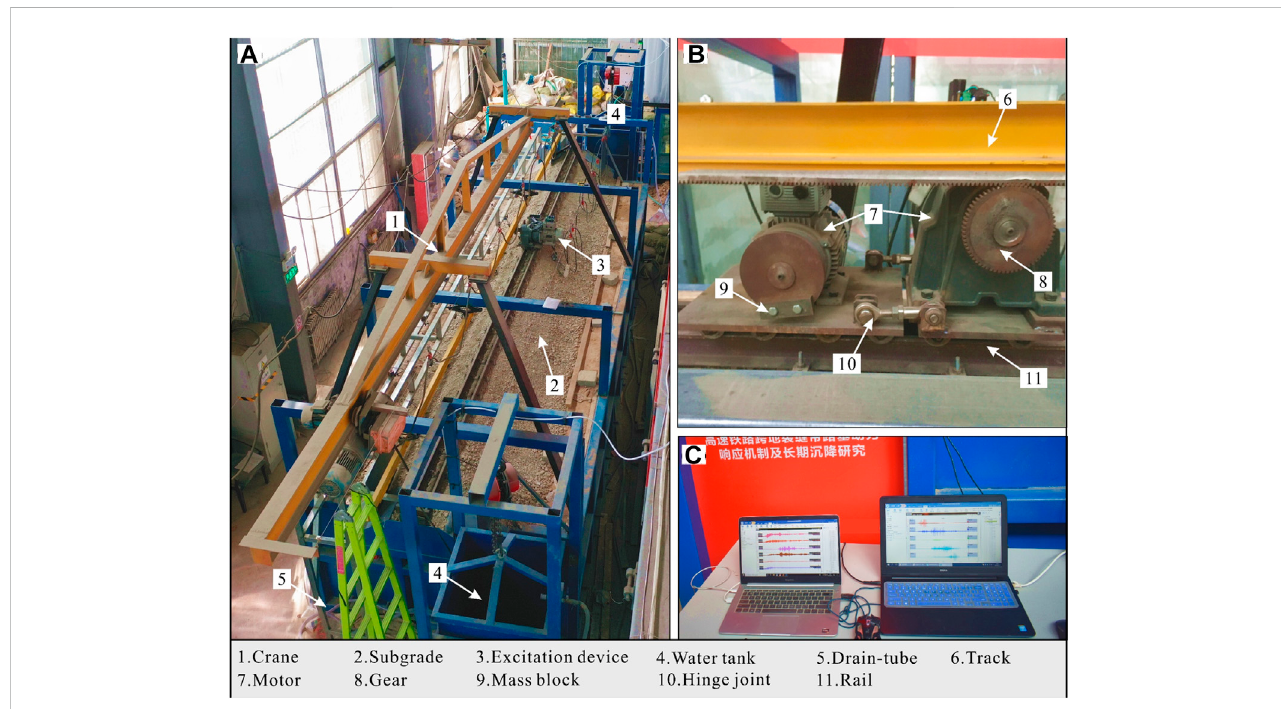
FIGURE 4 Model test device. (A) new experimental facility; (B) excitation device; (C) measured data.